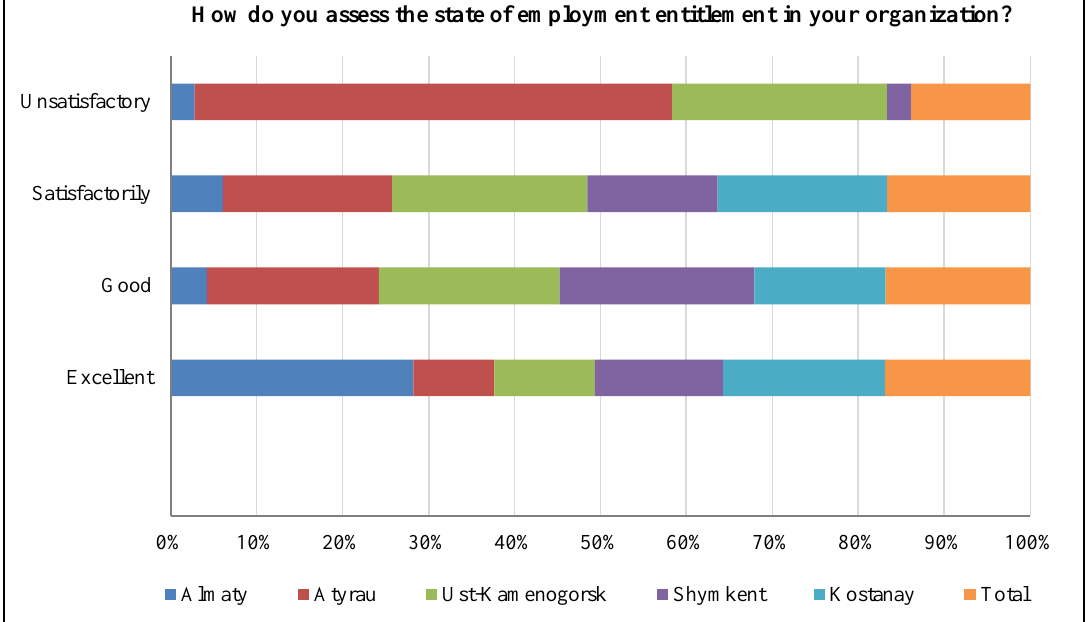
Figure 4. Data on respondents’ employment entitlement